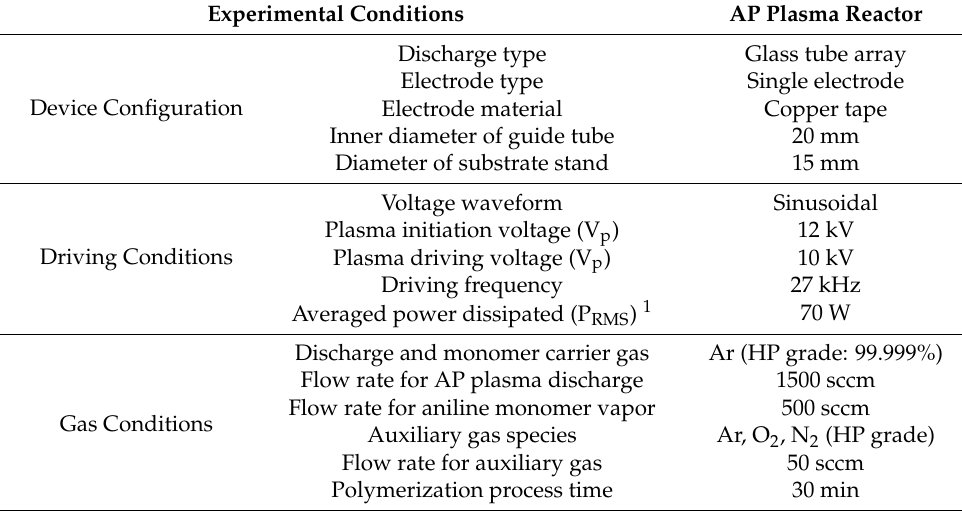
Figure 3. Optical images of glow plasmas during plasma polymerization: ( a ) bright image of the AP plasma reactor and ( b–e ) optical image inside the AP plasma reactor during polymerization; discharge images during polymerization ( b ) without auxiliary gas and ( c ) with the addition of Ar, ( d ) O 2 , and ( e ) N 2 . All auxiliary gases are added at a flow rate of 50 sccm. Table 1. Summarized experimental conditions for AP plasma polymerization with the addition of auxiliary gas.